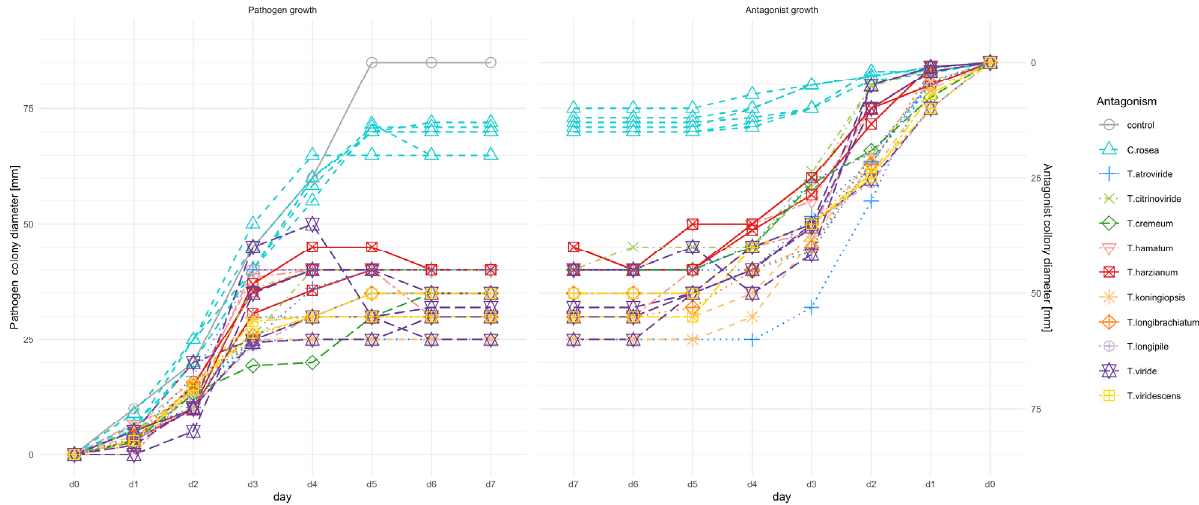
Figure 1. Visualization of reciprocal antagonist ( Trichoderma species or C. rosea strains) vs. pathogen ( F. culmorum KF846) growth on PDA medium during 7 days of incubation/co-incubation. Control- growth of F. culmorum in a single culture.